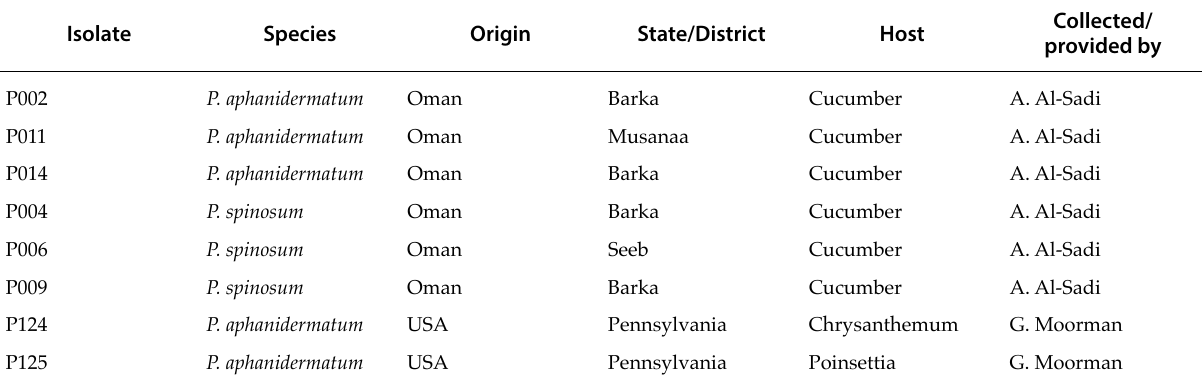
Table 1. isolates of Pythium aphanidermatum and P. spinosum used in the inactivation and colonization experiments. Isolate Species Origin State/District Host